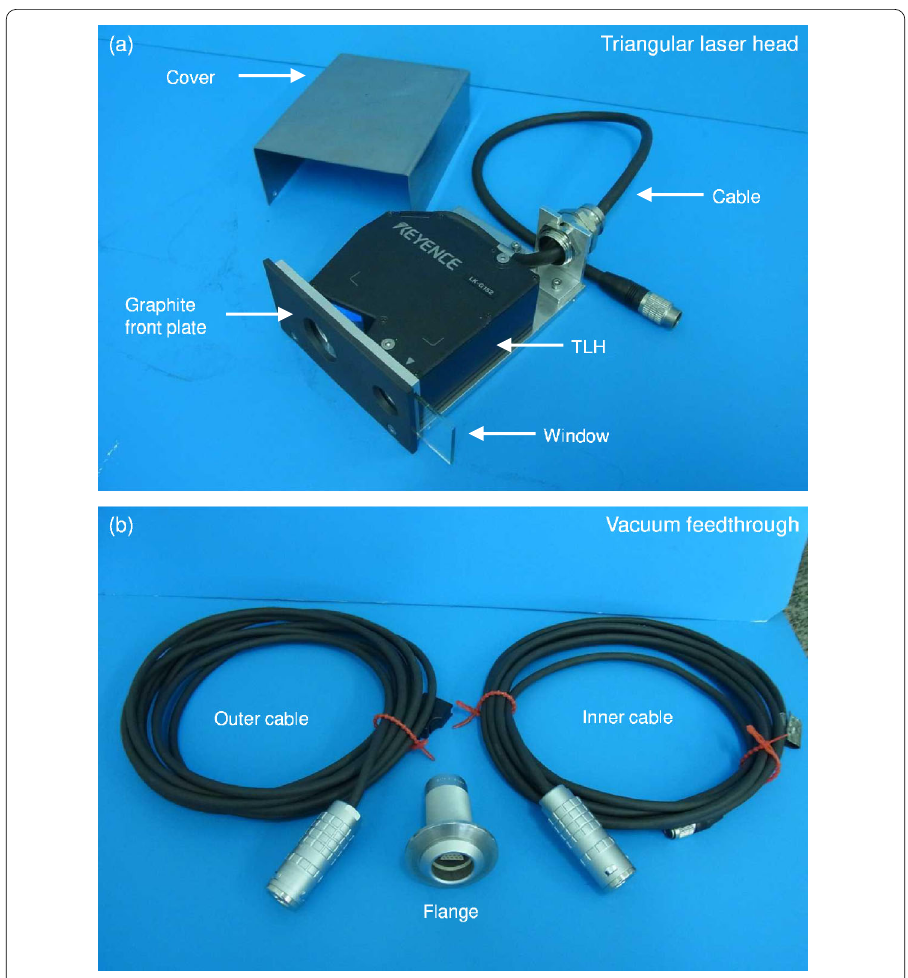
Figure 2 Experimental setup for insitu triangular laser head measurements: TLH with housing ( a ) and vacuum feedthrough with cables ( b